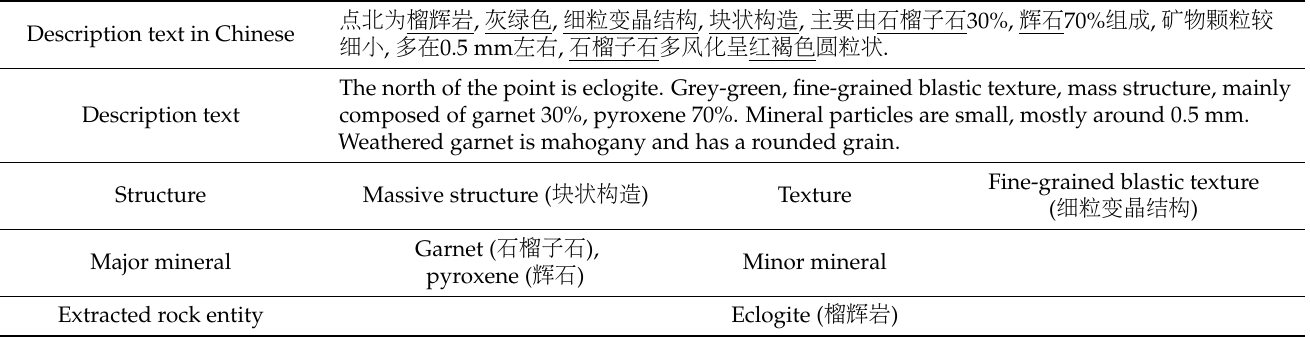
Table 3. An example of description text extraction for eclogite.